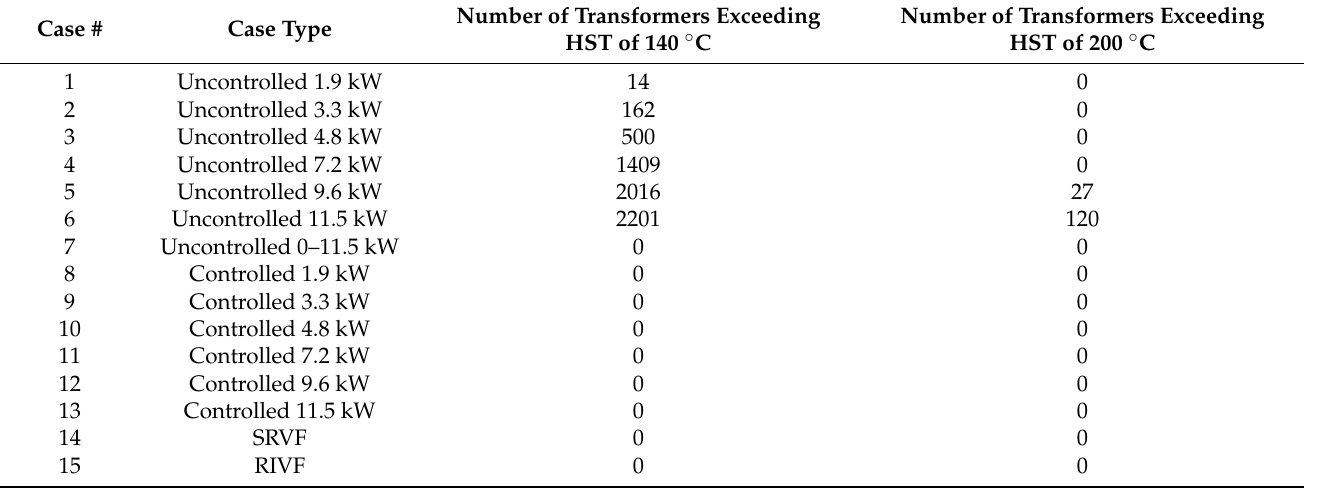
Figure 8. Hot spot temperature for the baseload. Table 9. Number of transformers exceeding the HST